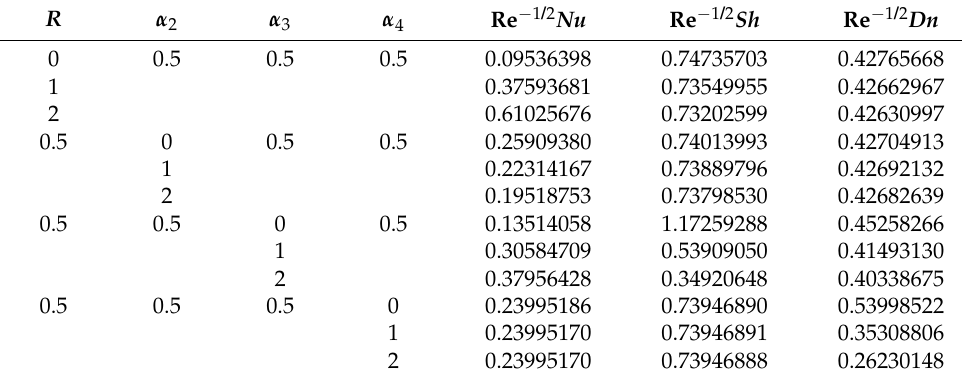
Table 3. The values of Re − 1/2 Nu , Re − 1/2 Sh , and Re − 1/2 Dn for different values of R , α 2 , α 3 , and α 4 when Pr = 6, α 1 = R = Ha = m = Nb = 0.5, Ec = Nt = Pe = 0.1, Re = 1, Le = Lb = 3,